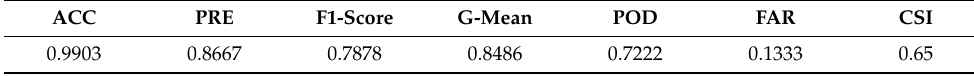
Table 4. The TDA-RF scores on the testing set.